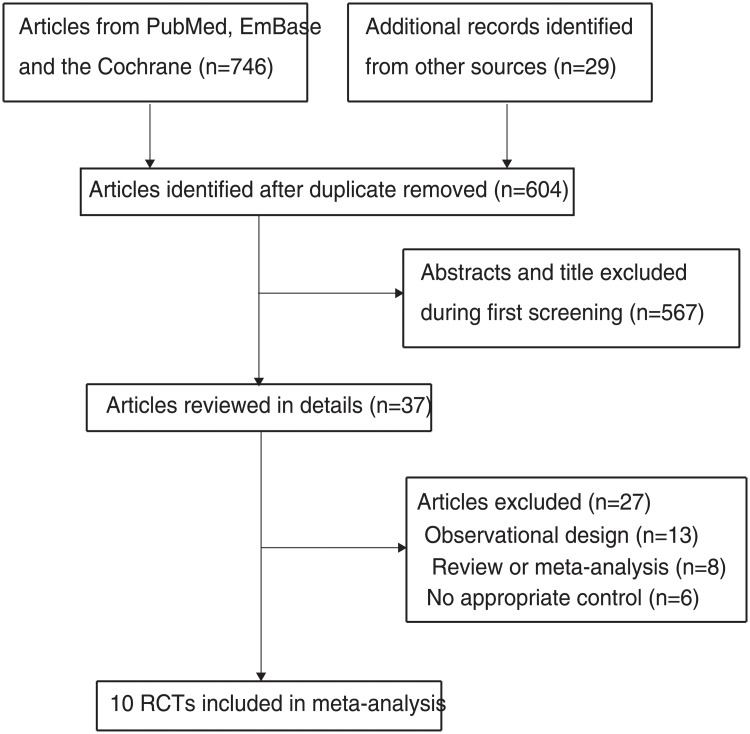
PRISMA flowchart for the study selection process.